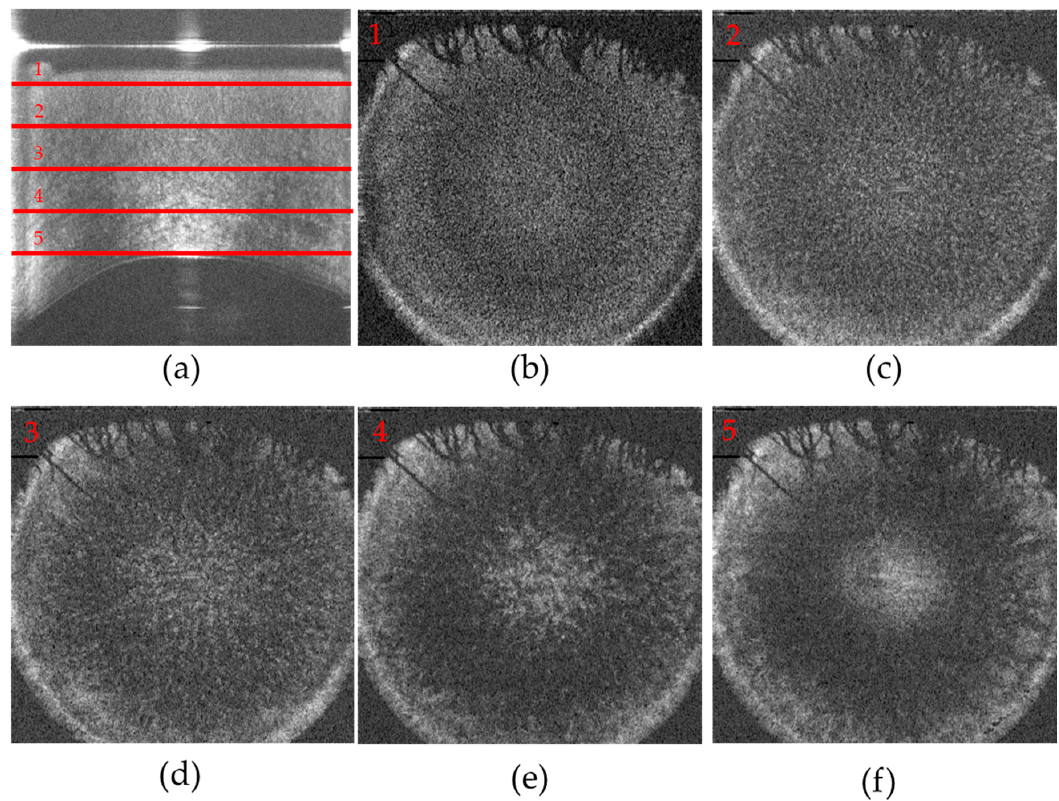
Figure 5. Volume data of the cornea recorded in the cross-polarized detection channel. ( a ) Representative B-scan (lateral average of 10 frames) The depth location of the corresponding en-face images is marked with red horizontal lines; ( b )–( f ) En-face frames retrieved at a depth of 100, 200, 300, 400, 500 pixels (101, 202, 303, 404, 505 µm) from the corneal surface (cf. red lines 1–5 in (a); The field of view of (a) is 11 mm (x) and 860 µm (z), of Figure 5b–f is 11 mm (x) and 11 mm (y).